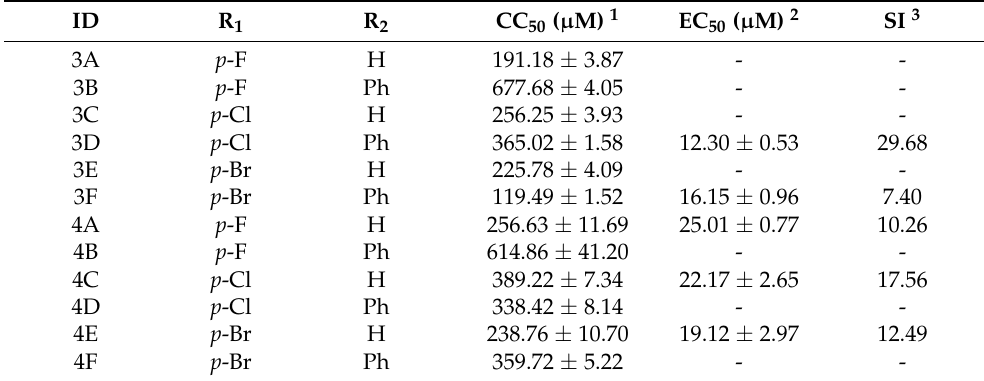
Table 1. Anti-viral activity against A/Weiss/43 H1N1 of synthetic compounds in Madin–Darby canine kidney (MDCK)